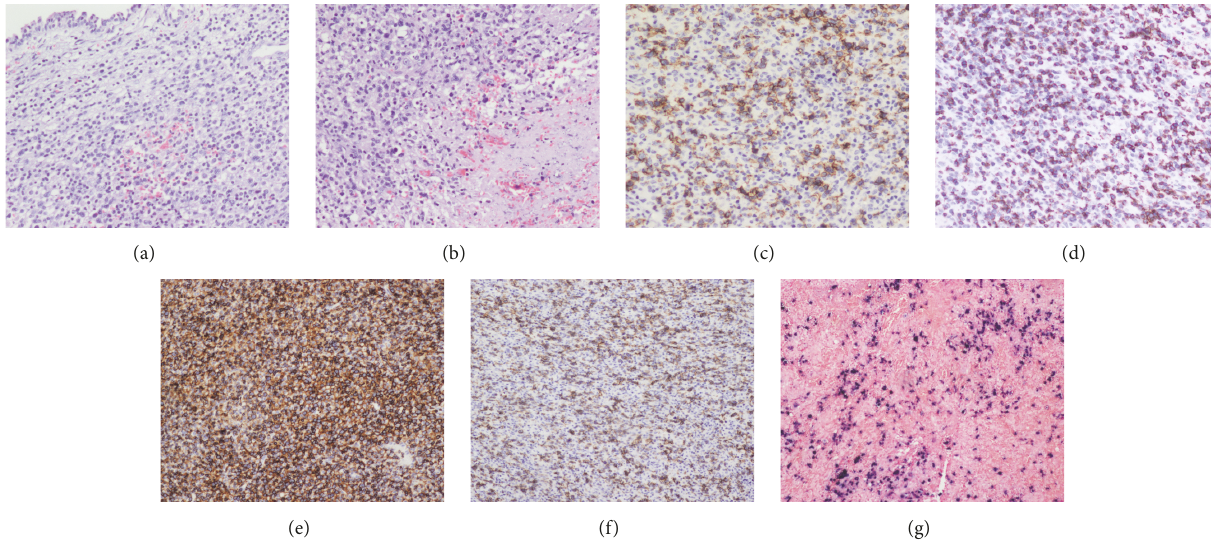
Figure 3: Pathological photomicrographs demonstrated that the mucosa was intact and expanded by a diffuse infiltrate of lymphoma cells (a, H&E). The mucosal lymphoid infiltrate was destructive, resulting in necrosis. The medium-to-large transformed cell nuclei had an irregular nuclear folding with granular appearance (b, H&E). Positive immunohistochemical staining was recorded for (c) CD56, (d) CD3, (e) LCA,